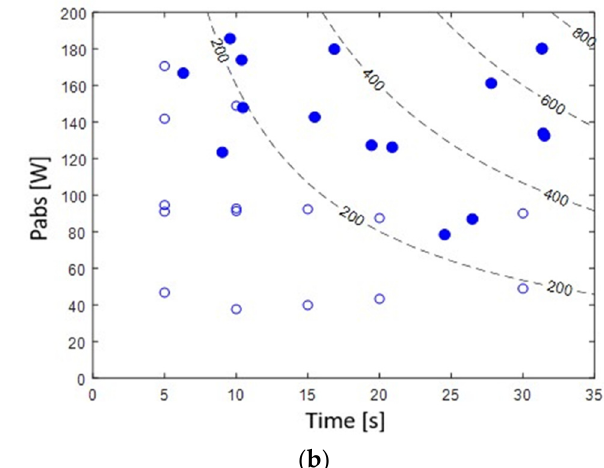
Figure 8. SEM and EDS images, showing a typical scanning LMH–AM grain structure ( a , b ), and the non-uniform spatial distribution of the main powder ingredients copper, tin, nickel, and phospho- rous, in ( c – f ), respectively. A mutually complementing pattern, typical to selective melting pro- cesses, is observed in this case.